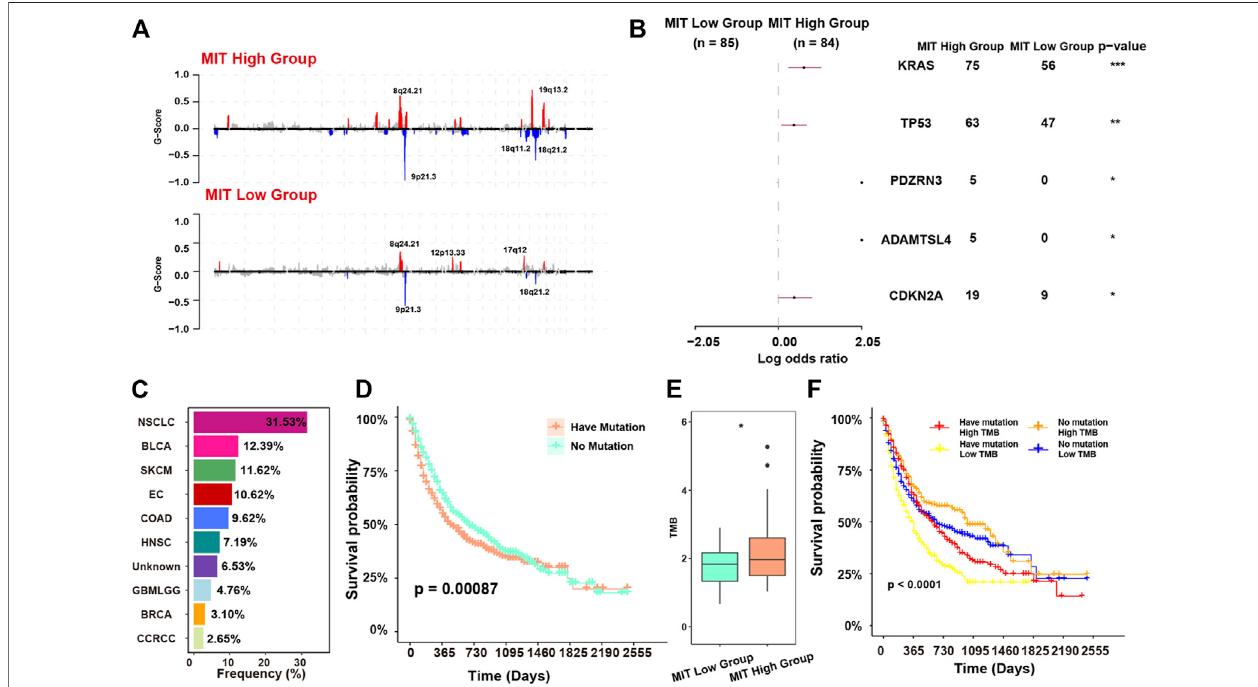
FIGURE 5 | MIT-associated oncogenic events and their relevance to ICB response. (A) , recurrent copy number events (GISTIC2 Q < 0.1) in MIT-high group (top panel) and MIT-low group (bottom panel). (B) , comparison of mutation rates of individual genes between the MIT high and MIT low groups. *, p -value < 0.05; **, p -value < 0.01; ***, p -value < 0.001 (C) , frequency of the mutation of KRAS, TP53, PDZRN3, ADAMTSL4 and CDKN2A in MSK-IMPACT dataset with ICB clinical information. (D) , Kaplan-Meier curves showing the survival difference between patients with no mutation and patients having mutation in MSK-IMPACT dataset with ICB treatment. The p -value is computed via a two-sided log-rank test. Have mutation indicates patients with any of KRAS, TP53, PDZRN3, ADAMTSL4 and CDKN2A mutations. (E) ,boxplotshowingtheTMBdifferencebetweenMIT-highgroupand MIT-lowgroup.*, p -value < 0.05fromtwo-sidedpairedStudent ’ st-test. (F) , The Kaplan-Meier curve showing the survival difference among four subgroups of patients. Have mutation representing patients with any of KRAS, TP53, PDZRN3, ADAMTSL4 and CDKN2A mutations. p -values were calculated using strati fi ed log-rank test.